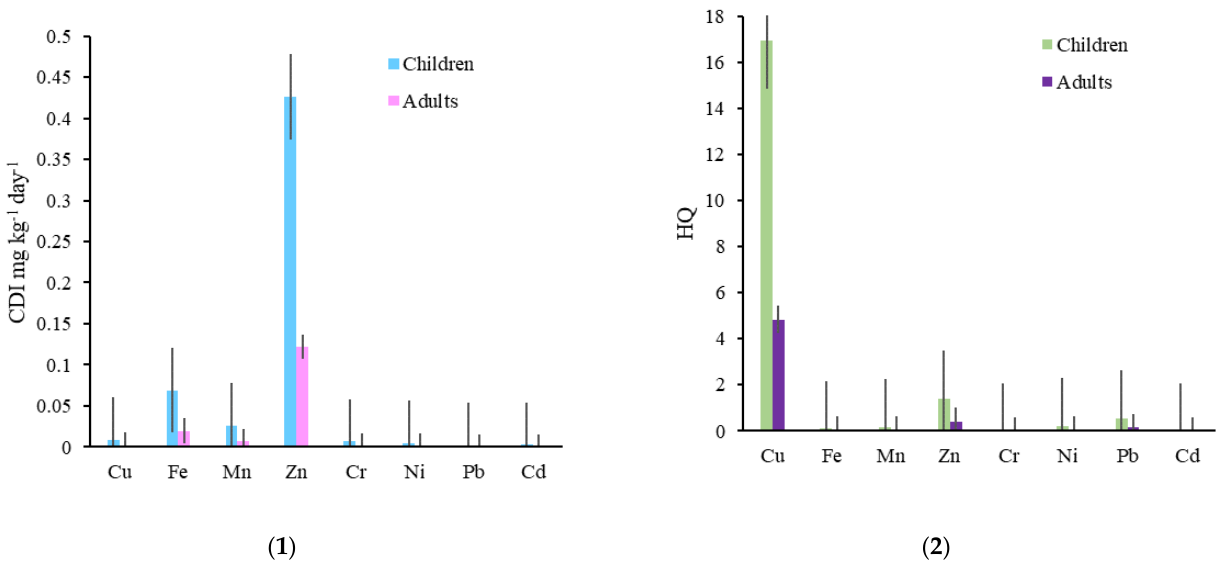
Figure 8. Risk assessment of heavy metals through water ingestion expressed as cumulated CDI ( 1 ) and HQ ( 2 ) scores for adults and children.